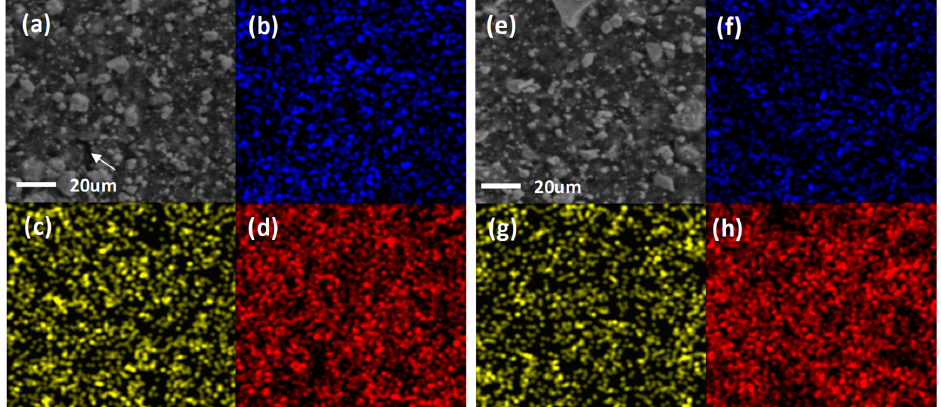
Figure 2. SEM images of the SbTe-C20 electrode prepared with ( a ) the PVDF binder and ( e ) the PAA binder. Sb, Te, and C EDS maps corresponding to: ( b – d ) panel a, and ( f – h ) panel